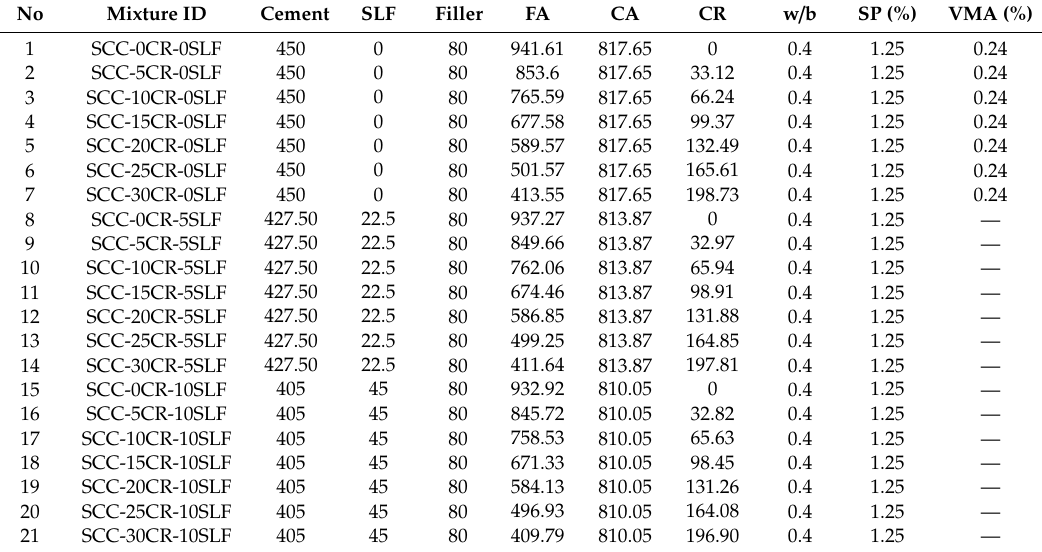
Table 4. Mix proportions for self-compacting concrete (kg / m 3 ). CA: coarse aggregate, CR: crumb rubber, FA: fine aggregate, SLF: silica fume, w / b: water to binder. No